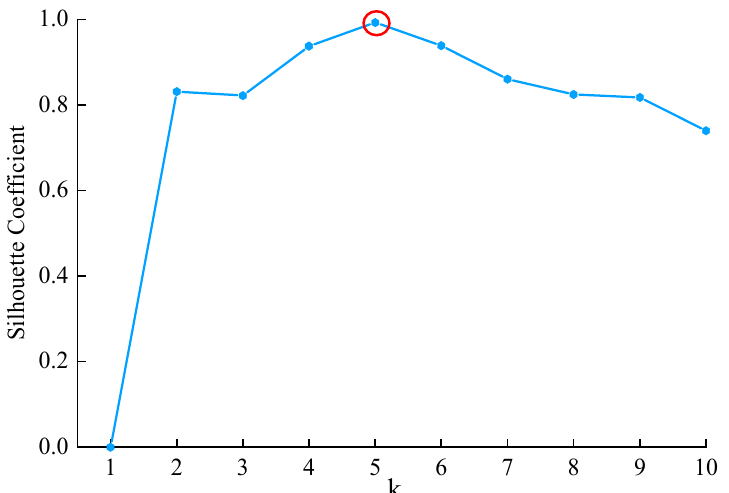
Figure 3. Weight values of completion quality: ( a ) comparison between EWM, AHP and quadratic programming; ( b ) comparison between linear combination weighting and quadratic programming method.